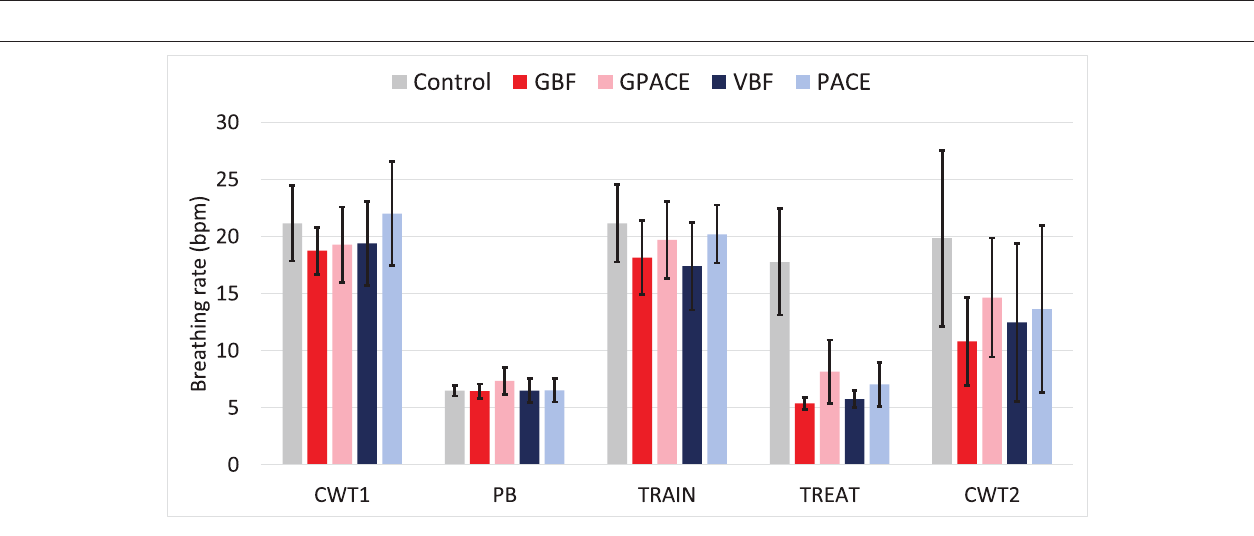
FIGURE 5 | Average breathing rate per group during Pre-Test (CWT1), paced breathing (PB), Training (TRAIN), treatment (TREAT), and Post-Test